Question: Provide a publication-style caption for this figure.
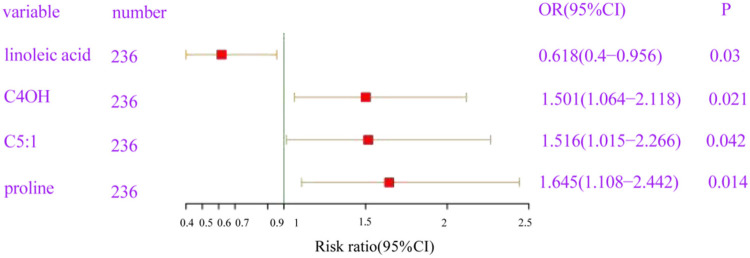
Answer: Multivariate stepwise logistic regression of prediction model in forest plot. The final model incorporated linoleic acid, C5:1, C4OH, and proline.